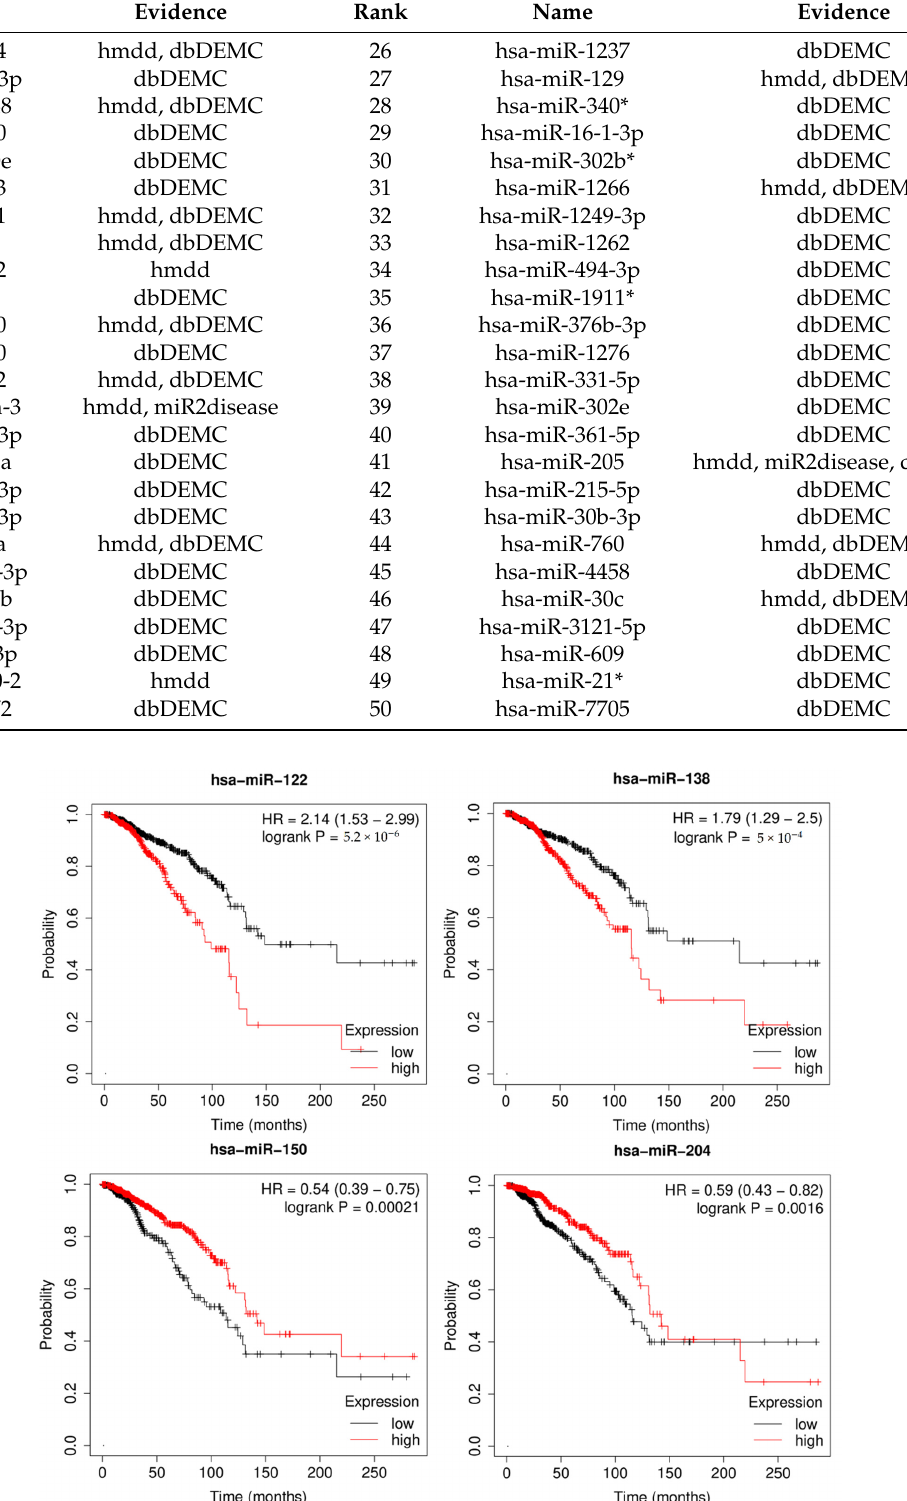
Figure 6. Kaplan–Meier plots of hsa-miR-520e, hsa-miR-593, hsa-miR-381, and hsa-miR-500a, for survival of breast cancer patients. Survival analysis demonstrated effectiveness of MDMF in discovering potential biomarkers.